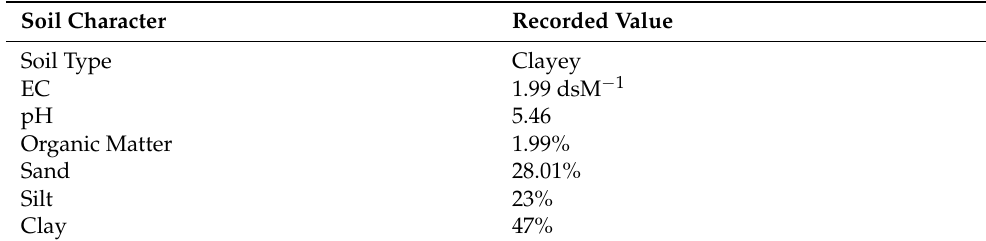
Table 1. Physiochemical features of experimental trial soil